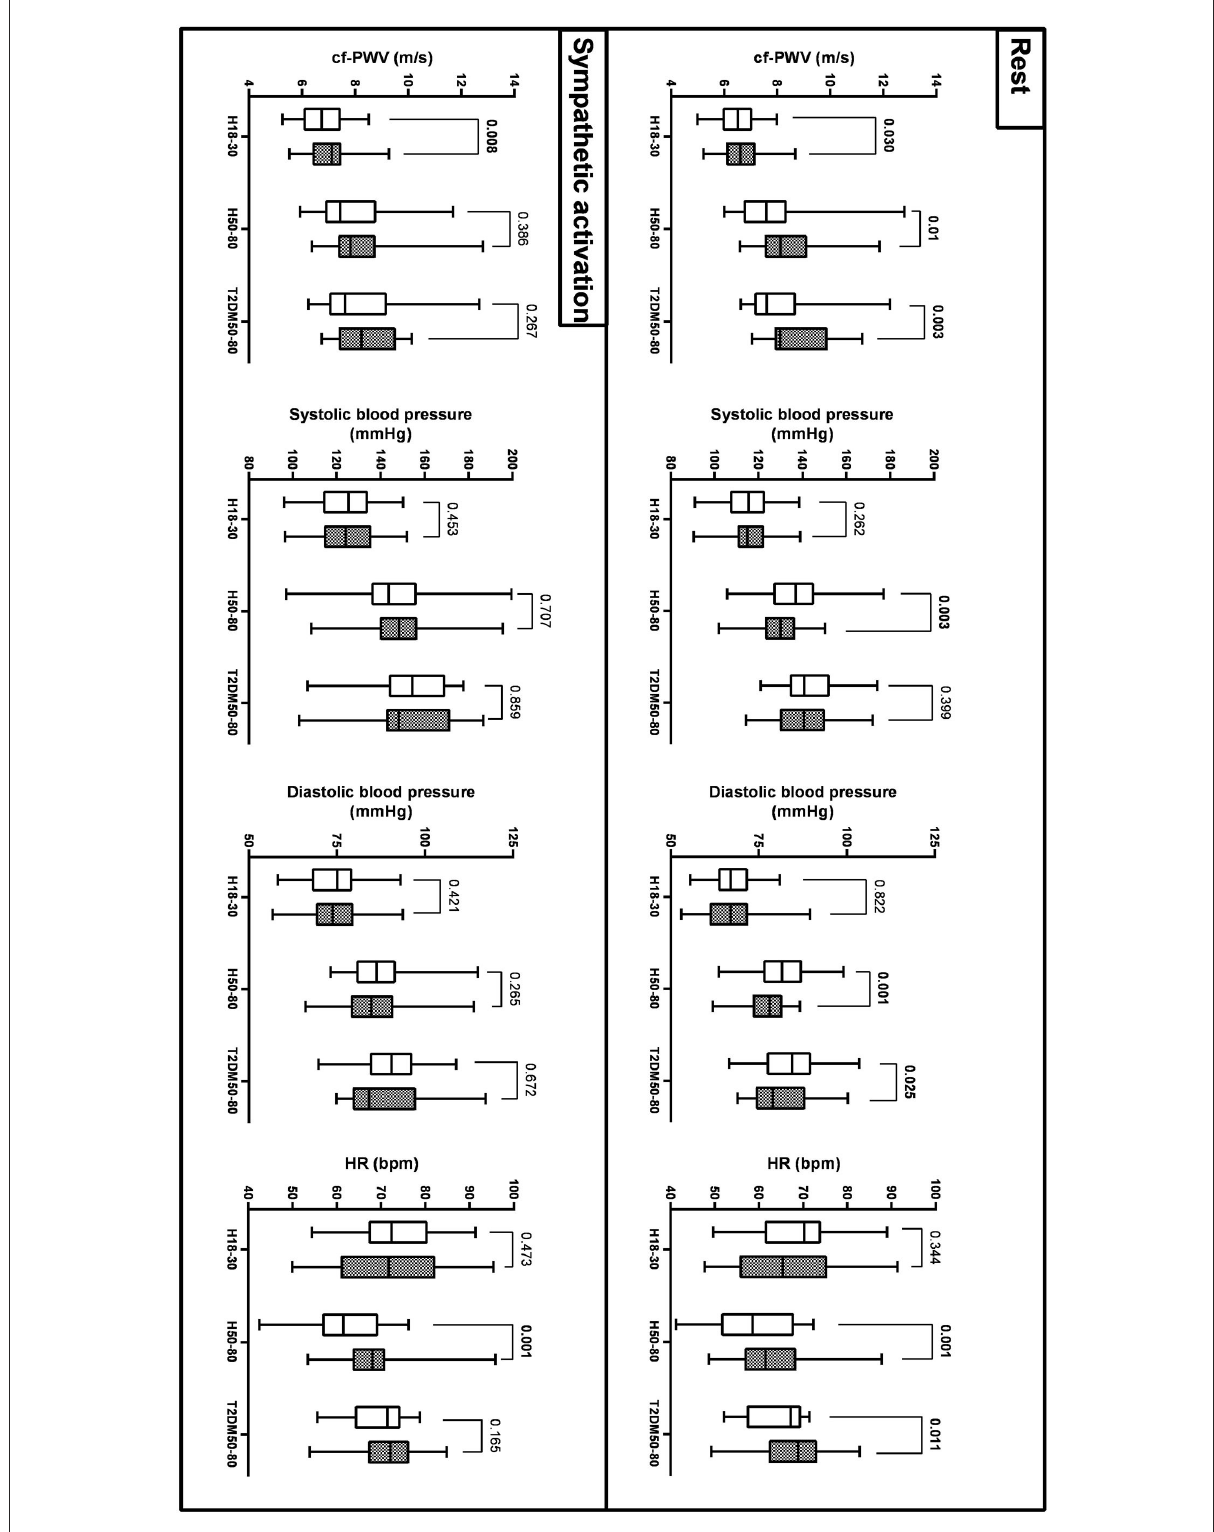
FIGURE1 Circadian variations (morning: empty bars; evening: filled bars) of cf-PWV, systolic AP, diastolic AP, and HR across the 3 groups at rest and during sympathetic activation (mean, Q1/4, Q3/4, and minimum and maximum